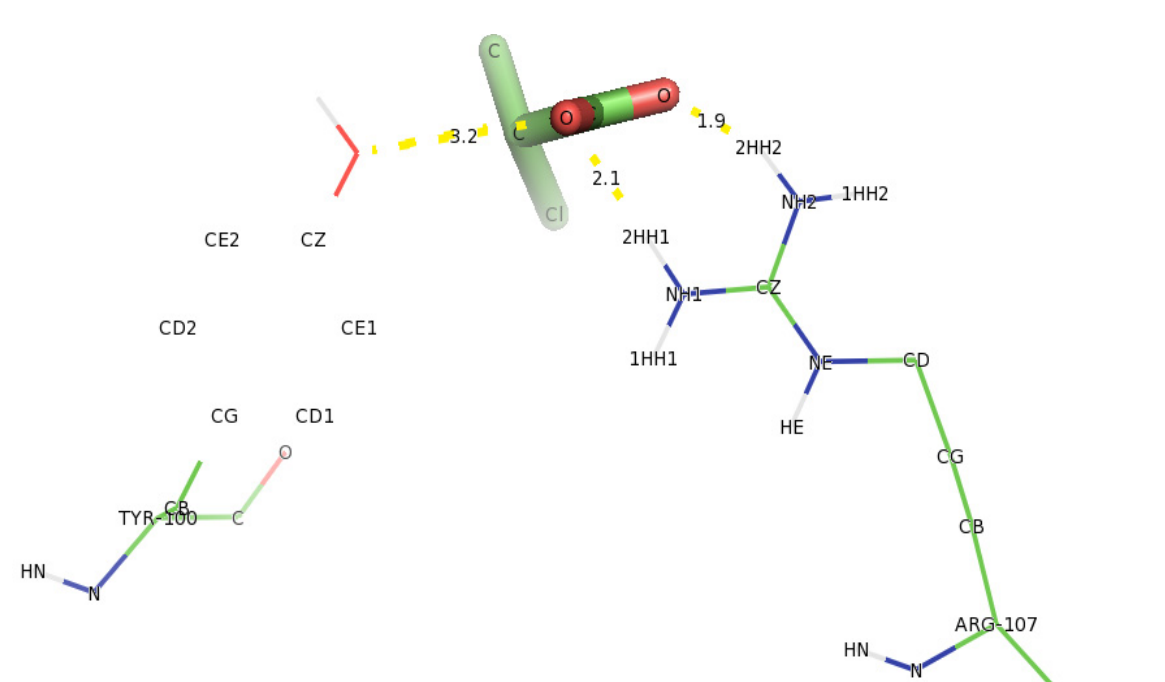
Figure 14. The interacting residues of DehD variant R134A with D -2CP. Hydrogen bond distances are in